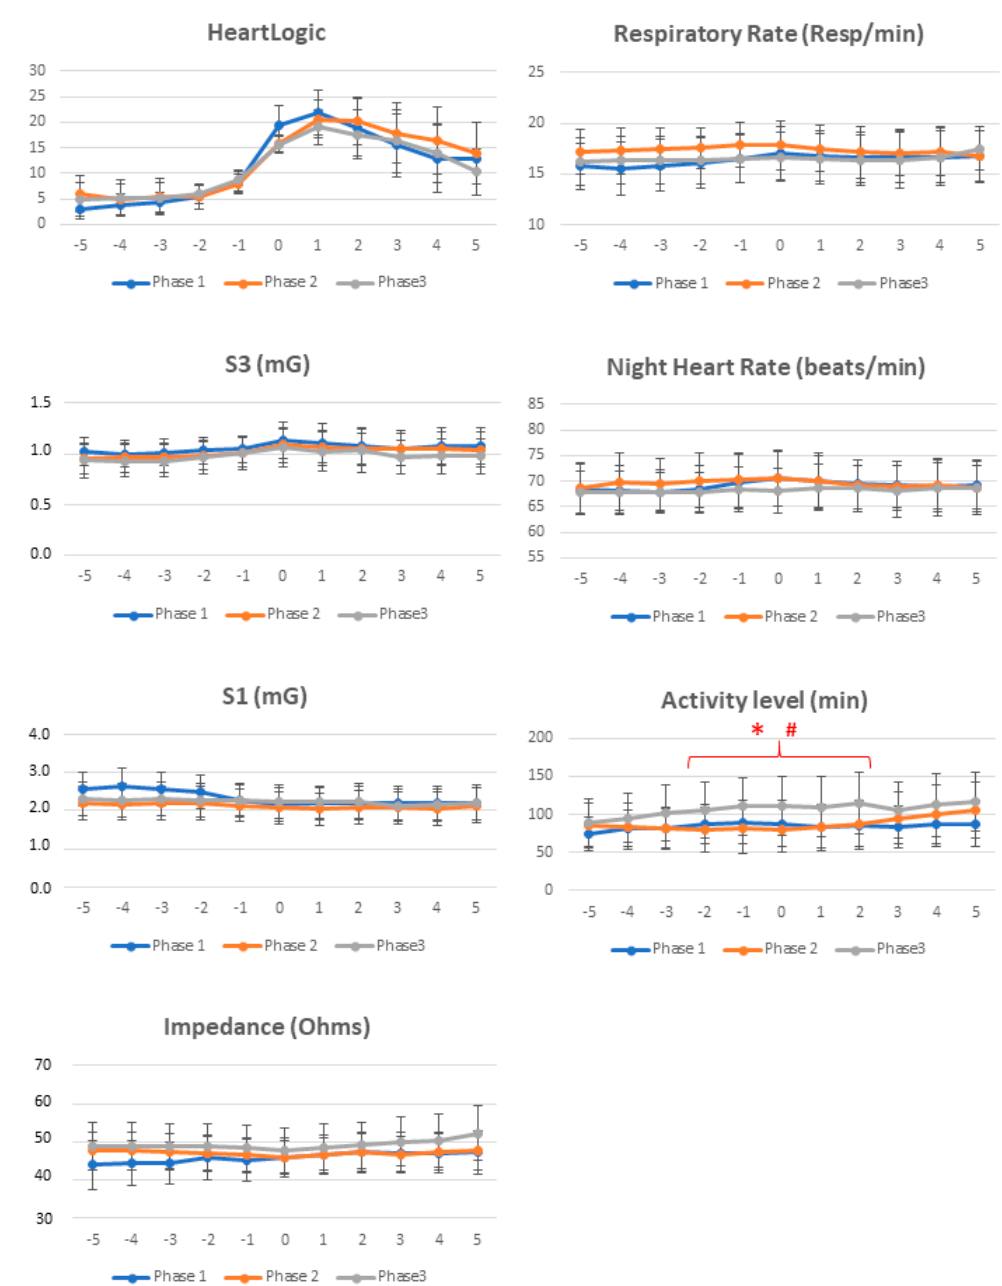
Figure 2. Comparison of trends collected immediately before and after the alerts among study phases. Weekly averages (with standard deviation) of HeartLogic index and all physiologic parameters are reported from 5 weeks before to 5 weeks after the alert onset (week 0). S1: First heart sound; S3: Third heart sound; *: p < 0.05 post-lockdown versus pre-lockdown; #: p < 0.05 post-lockdown versus lockdown.